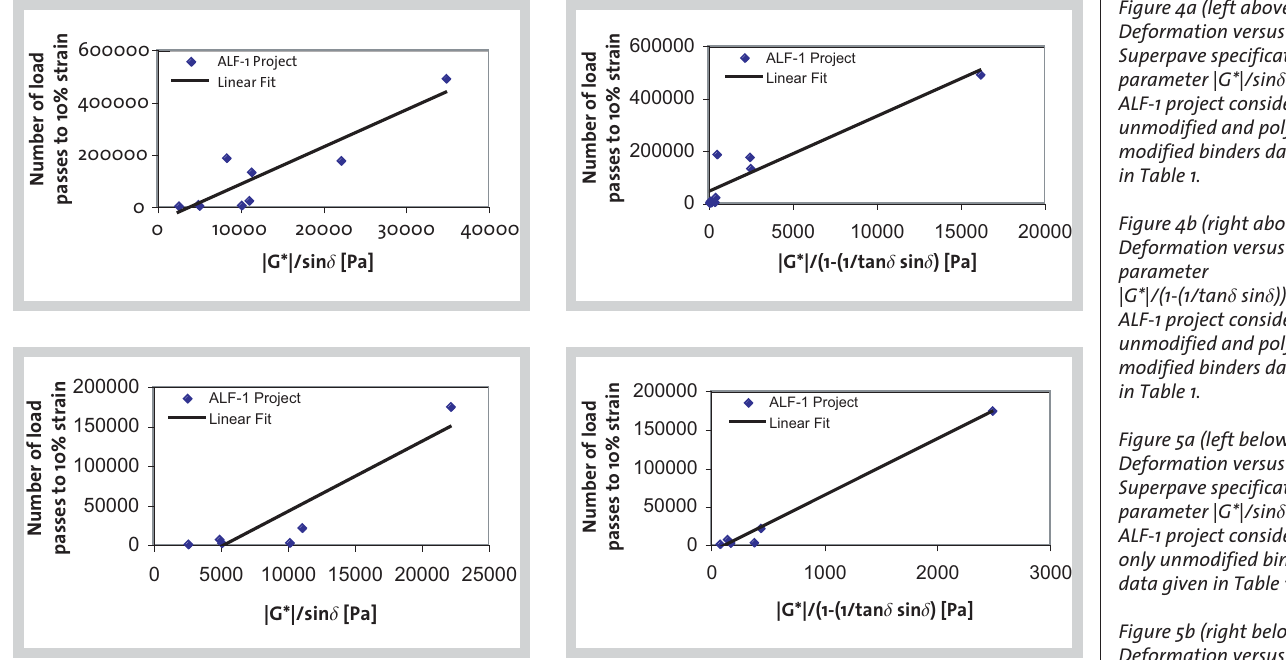
Figure 4a (left above): Deformation versus the Superpave specification parameter |G*|/sin d from ALF-1 project considering unmodified and polymer- modified binders data given in Table 1. Figure 4b (right above): Deformation versus the parameter |G*|/(1-(1/tan d sin d )) from ALF-1 project considering unmodified and polymer- modified binders data given in Table 1. Figure 5a (left below): Deformation versus the Superpave specification parameter |G*|/sin d from ALF-1 project considering only unmodified binders data given in Table 1. Figure 5b (right below): Deformation versus the parameter |G*|/(1-(1/tan d sin d )) from ALF-1 project considering only unmodified binders data given in Table